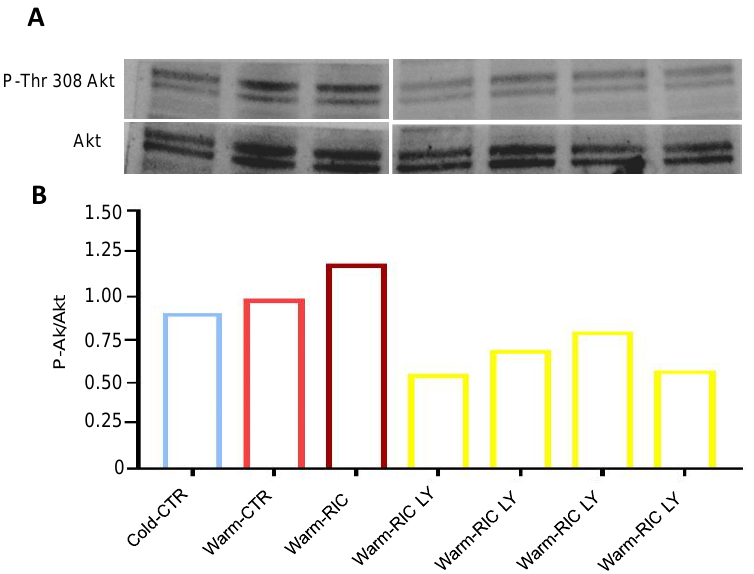
Figure 3. Western blot bands ( A ) and quantifications of phospho-Akt/Akt ratio ( B ) showing the effects of Akt phosphorylation inhibition following treatment with LY294002 in warm-RIC hearts compared to untreated warm-RIC and warm-CTR. Cold-CTR hearts are used as a reference group.